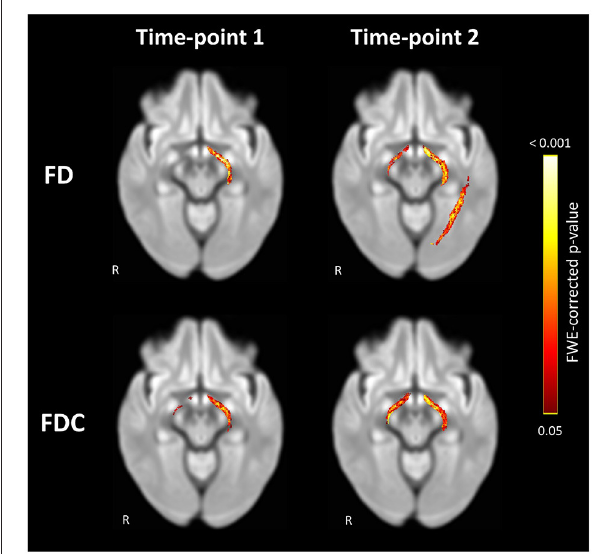
FIGURE 2 | Significant loss of FD and FDC in the visual pathways of POAG patients compared to controls at Time-point 1 and Time-point 2. Loss of FD was found in the left OT at Time-point 1 and in both OTs and left OR at Time-point 2. Loss of FDC was found in both OTs at both time-points. Streamlines corresponding to fixels exhibiting significant (FWE-corrected P < 0.05) loss are overlaid on a representative axial slice of the inter-subject population template and colored according to their p -values. Images are shown in radiologic convention. FD, fiber density; FDC, fiber density and bundle cross section.